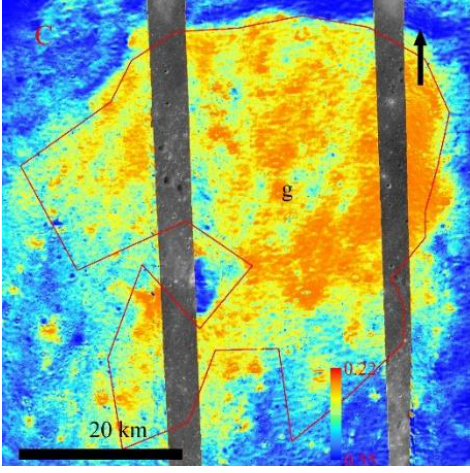
Figure 7. ( A ) CE-2 DOM mosaic (central location: 174.88° W, 37.52° S) of the mapped basalt unit (1 ， 280 km 2 ) in Davisson crater. The central peak and clustered secondaries (arrows) are excluded when map the counting area. ( B ) Local topography shown in SLDEM, and the elevation ranges from − 13,007 m to − 2,760 m as coded from blue to red in this figure. ( C ) FeO content map [24] of the counting area, and the values range from 1.94% to 21.94% as coded from blue to red in this figure. The red polygon in each sub-figure is the outlined representative crater count area. North is up in all sub-figures.